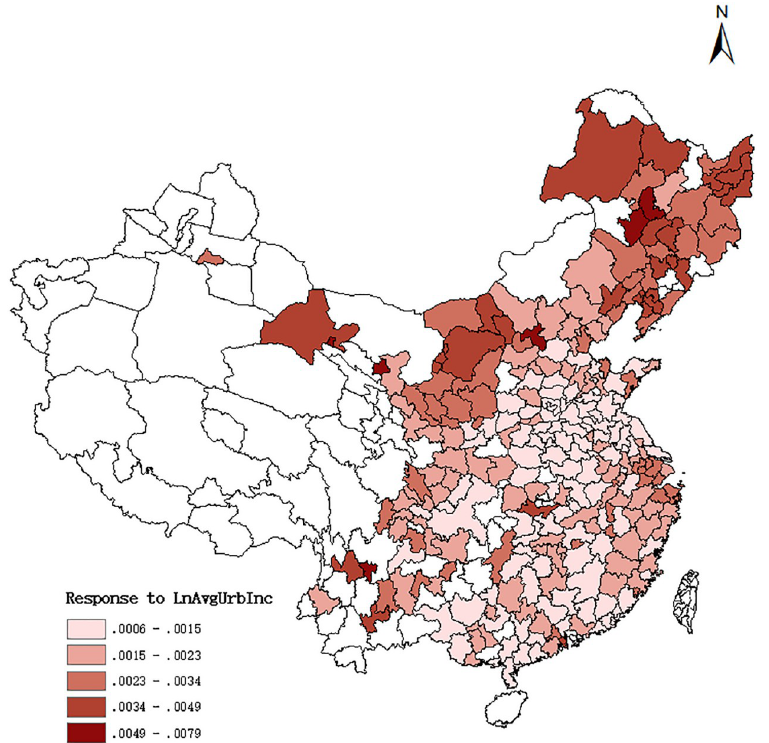
Fig 3. Response of homicide rate to a one-std.dev. Increase in Urban Average